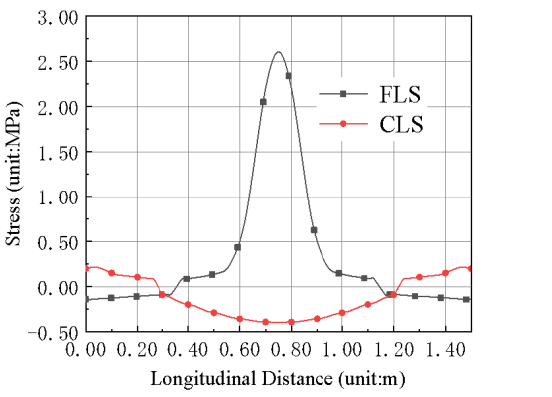
Figure 8. Stress distribution on link-slab under the second phase dead load.